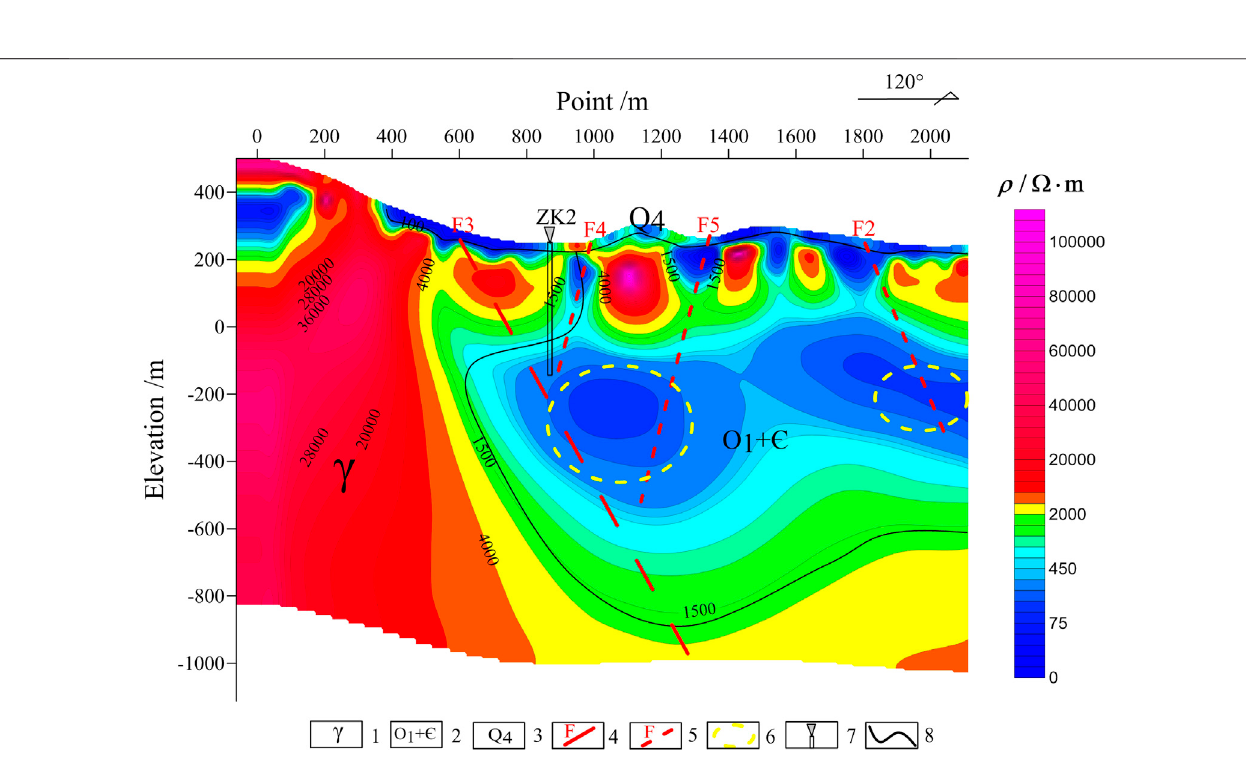
Frontiers in Earth Science |